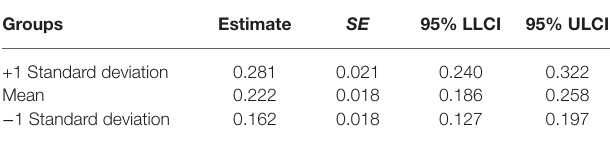
TABLE 4 | Conditional indirect effects of school leadership (SL) on student achievement (SA) moderated by collaborative culture (CC).